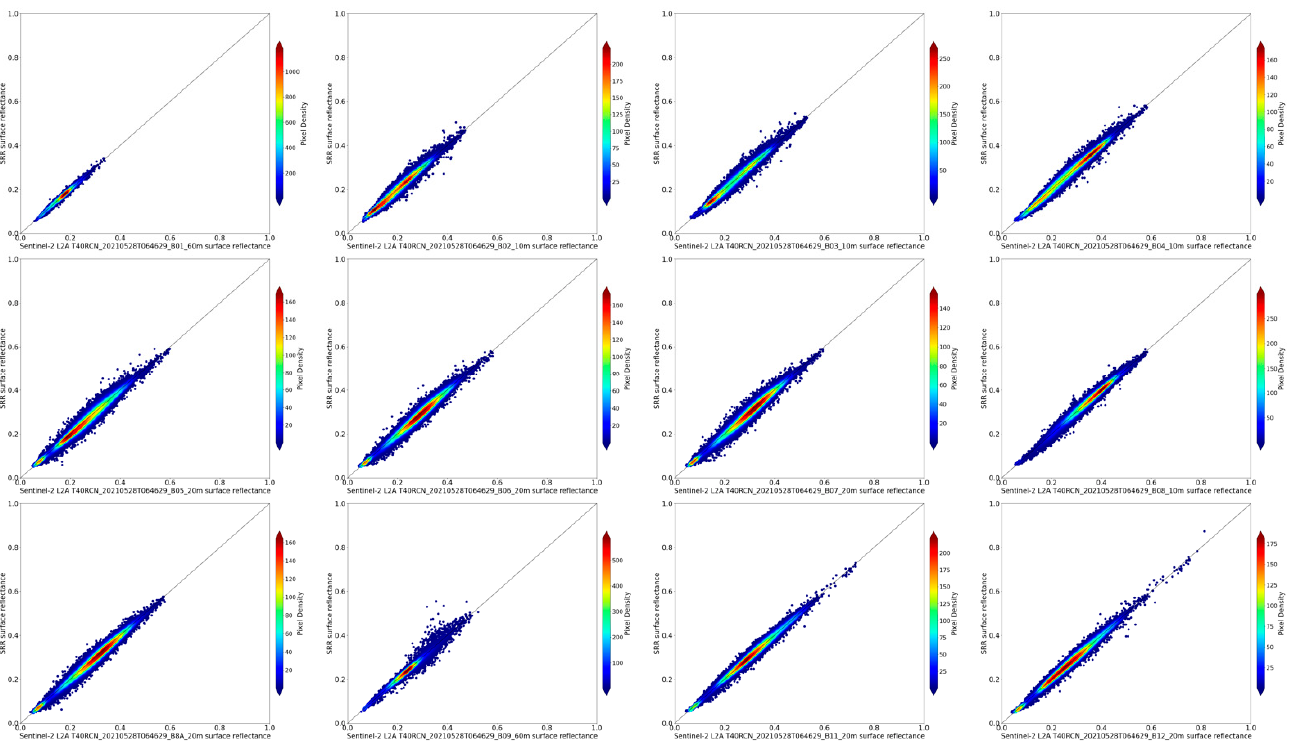
Figure 15. Site-2 intercomparisons of all spectral bands of the SRR product against the original Sentinel-2 L2A surface reflectance product (S2B_MSIL2A_20210528T064629_N0300_R020_T40RCN_20210528T091914).